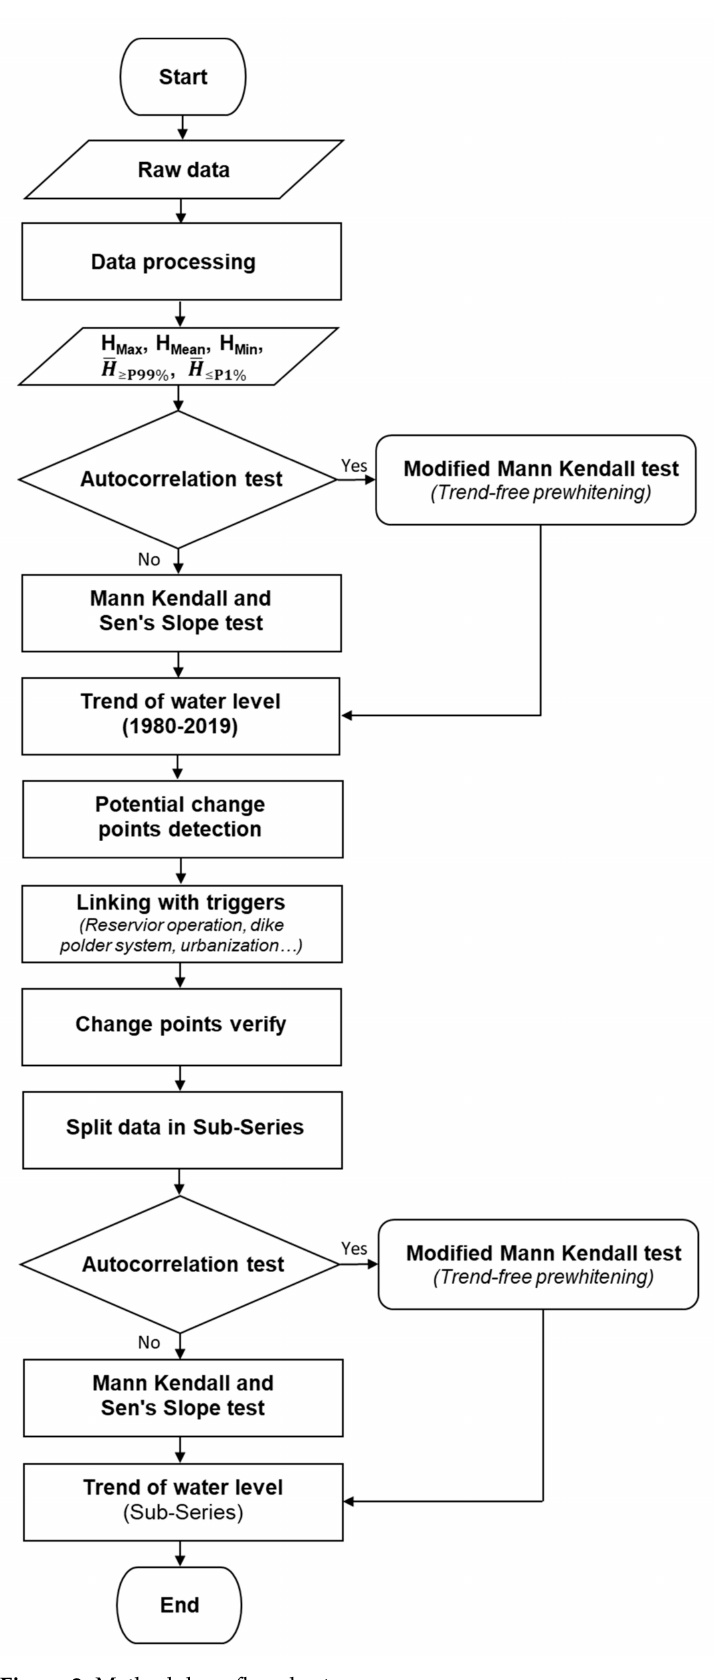
Figure 2. Methodology